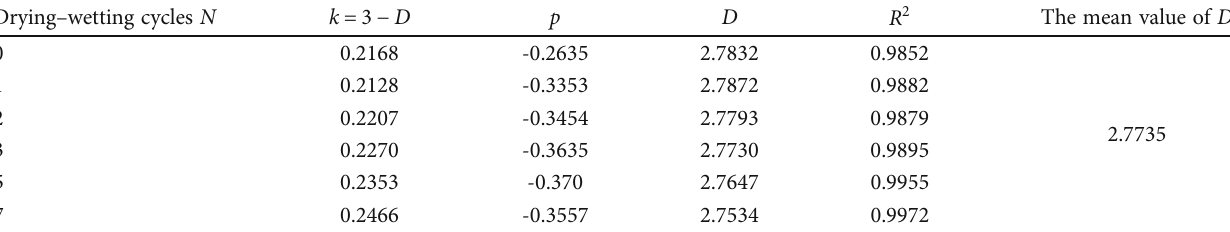
Table 7: Determination of the values of fractal dimension of drying – wetting cycle